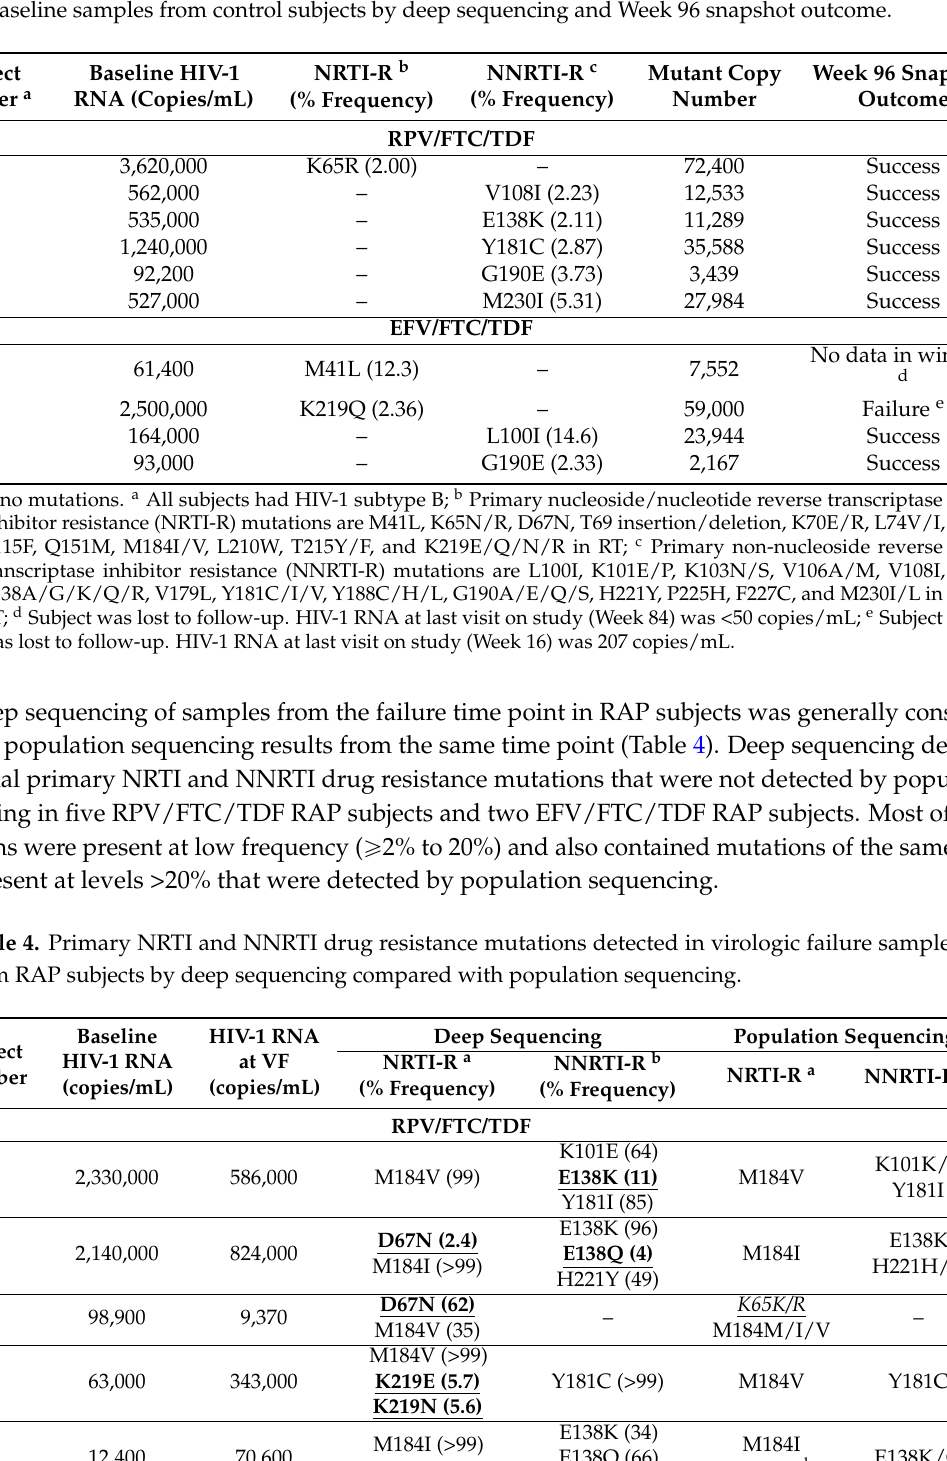
Table 3. Primary NRTI and NNRTI drug resistance mutations detected at low frequency ( ě 2% to 20%) in baseline samples from control subjects by deep sequencing and Week 96 snapshot outcome.